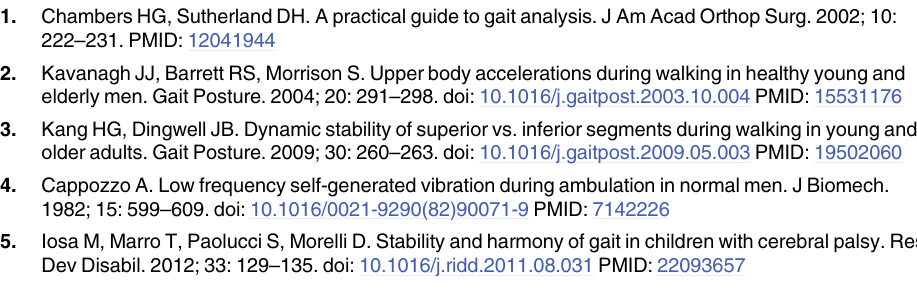
having no trends that can fi t the scattered CP group